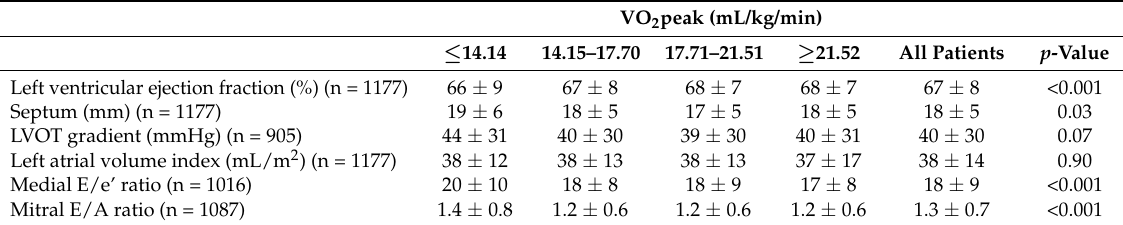
Table 2. Echocardiographic data stratified by peak VO 2 .